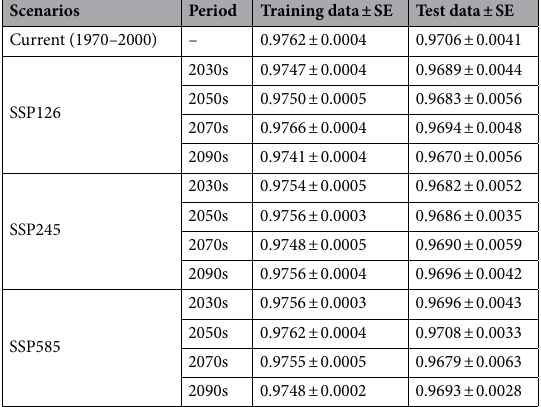
Table 1. AUC values of MaxEnt model for N. californicus under climate change